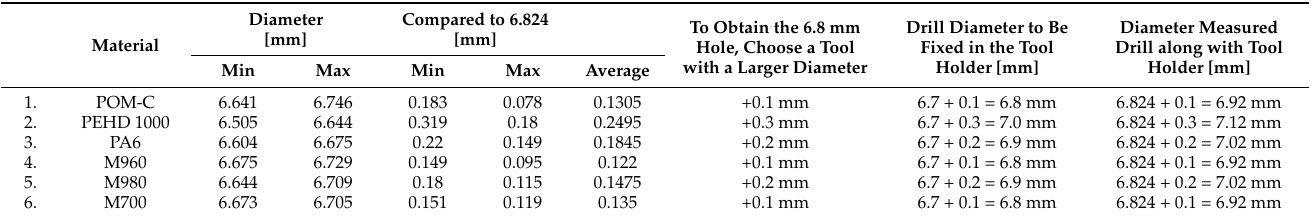
Table 8. Recommendations about the choice of the diameter of the drill to obtain the hole with the prescribed (designed) diameter.